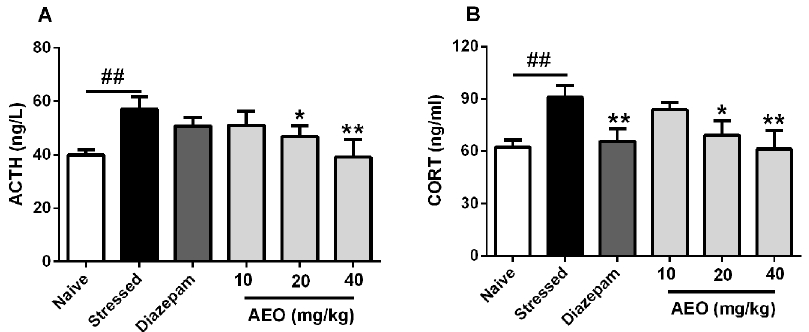
Figure 9. Effects of AEO on ( A ) adrenocorticotropic hormone (ACTH) and ( B ) corticosterone (CORT) concentrations in the serum of restraint stress-induced mice. Each value represents mean ± SEM with n = 8, ## p < 0.01 vs. the naive group, * p < 0.05 and ** p < 0.01 vs. the stressed group.